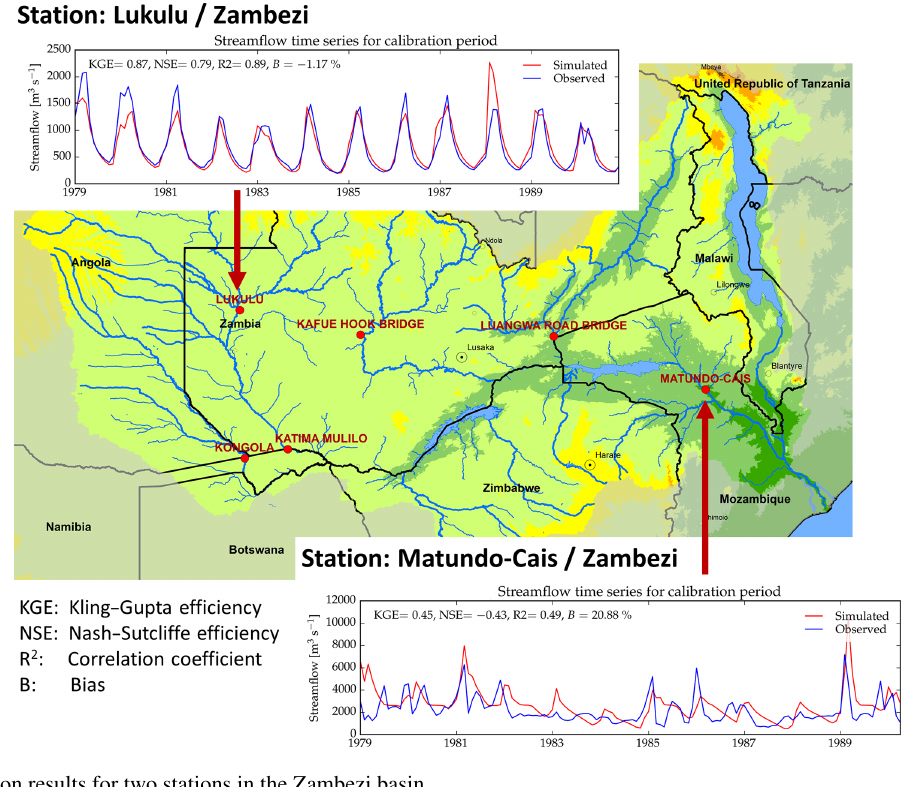
Figure 9. Calibration results for two stations in the Zambezi basin.